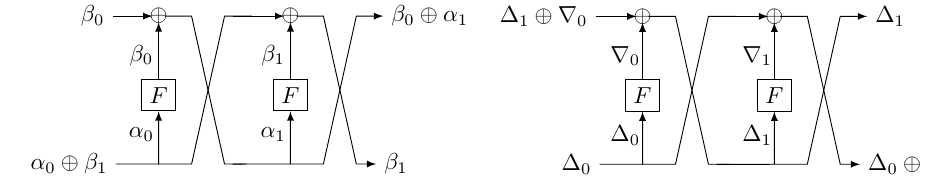
Figure 1: An illustration of how linear approximations/differentials over the F -functions of two consecutive Feistel rounds determine a linear approximation/differential over those rounds.